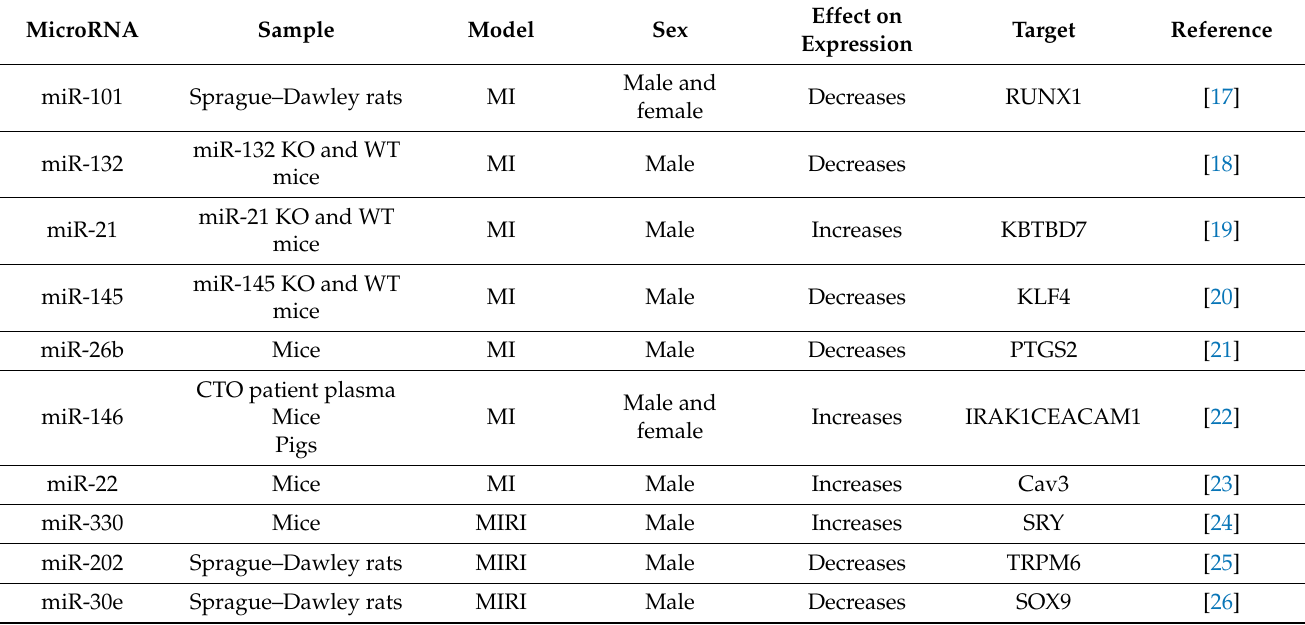
Table 1. microRNAs involved in cardiac